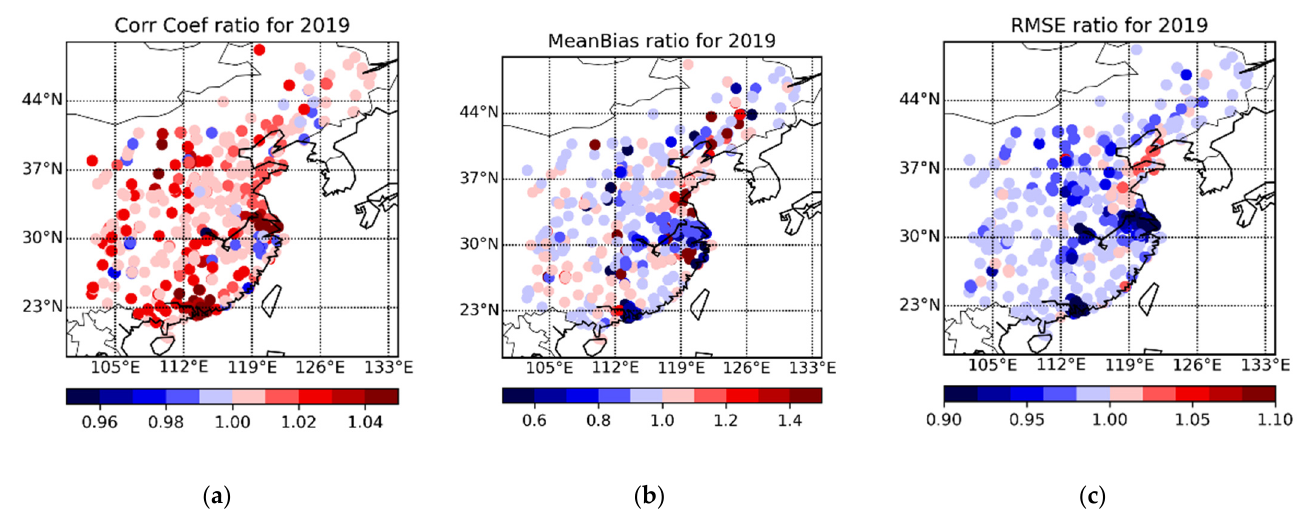
Figure 4. Ratios of the Conc_Prior19 and Conc_Post19 statistical indicators: correlation coefficient, mean bias and RMSE, respectively ( a – c ), for 2019.